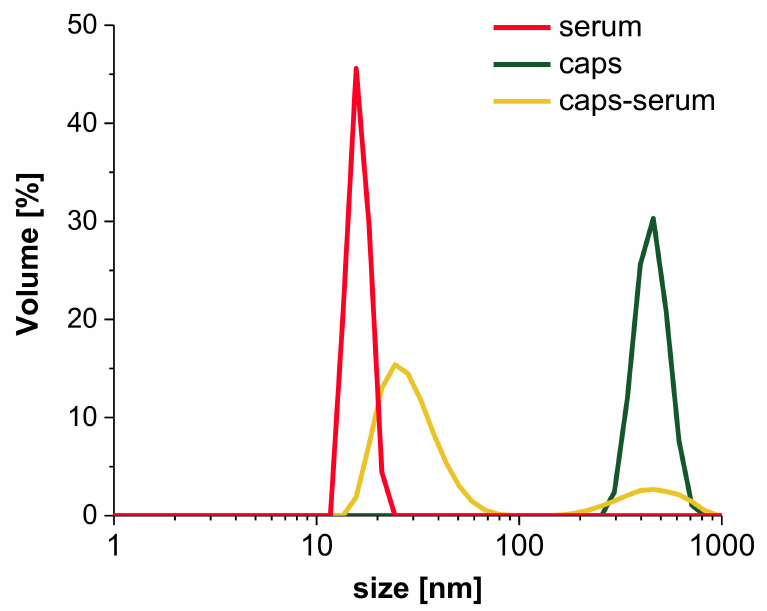
Figure 5. Representative volume-weighted particle size distributions of serum, the capsules and capsules interacting with serum, determined by dynamic light scattering (DLS)